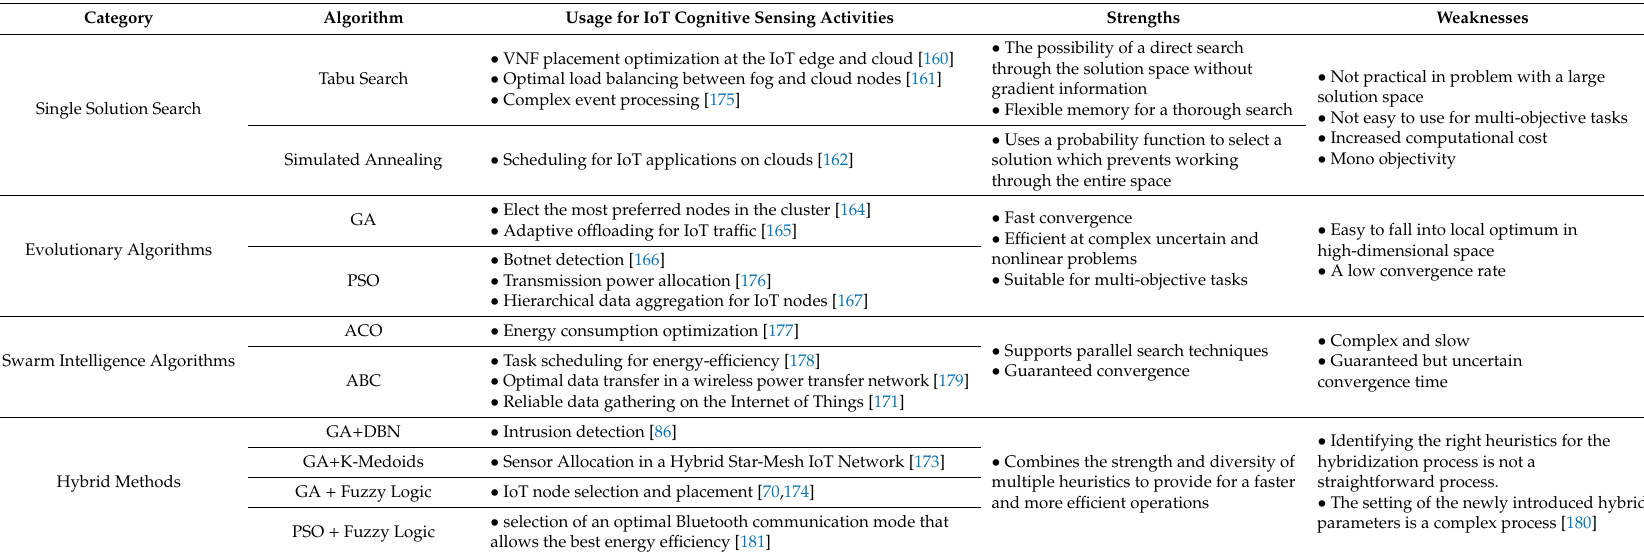
Table 7. Some metaheuristics and selected works detailing their strength and weaknesses for cognitive sensing